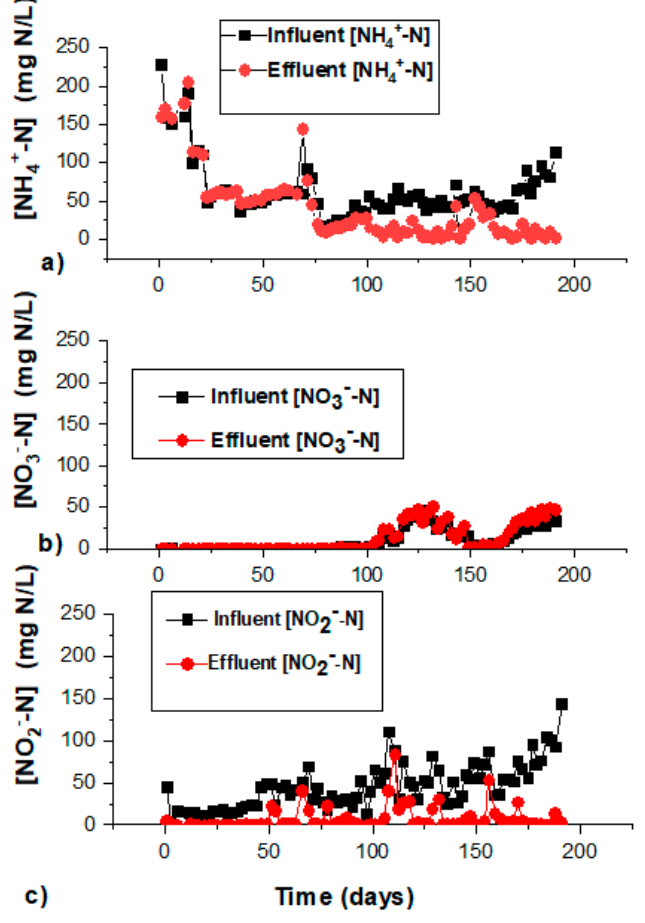
Figure 2. The time courses of ( a ) NH 4 + in the influent and effluent within the start-up period; ( b ) NO 3 − in the influent and effluent within the start-up period; and ( c ) NO 2 − in the influent and effluent within the start-up period.